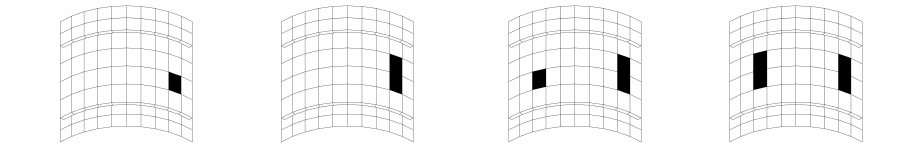
Figure 11. Stiffened fuselage section problem, Case (2), macroscale analysis: optimal sensor placement corresponding to (from left to right): N M = 1; N M = 2; N M = 3 and N M = 4.